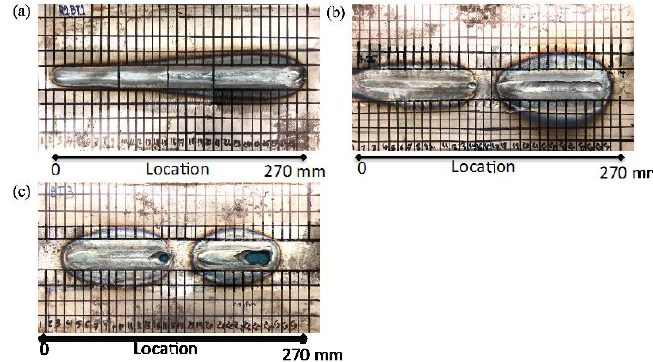
Figure 7. Weld coupons with different degrees of burn-through defect: ( a ) weld coupon No. 1; ( b ) weld coupon No. 2; and ( c ) weld coupon No. 3. coupon No. 2; and ( c ) weld coupon No.